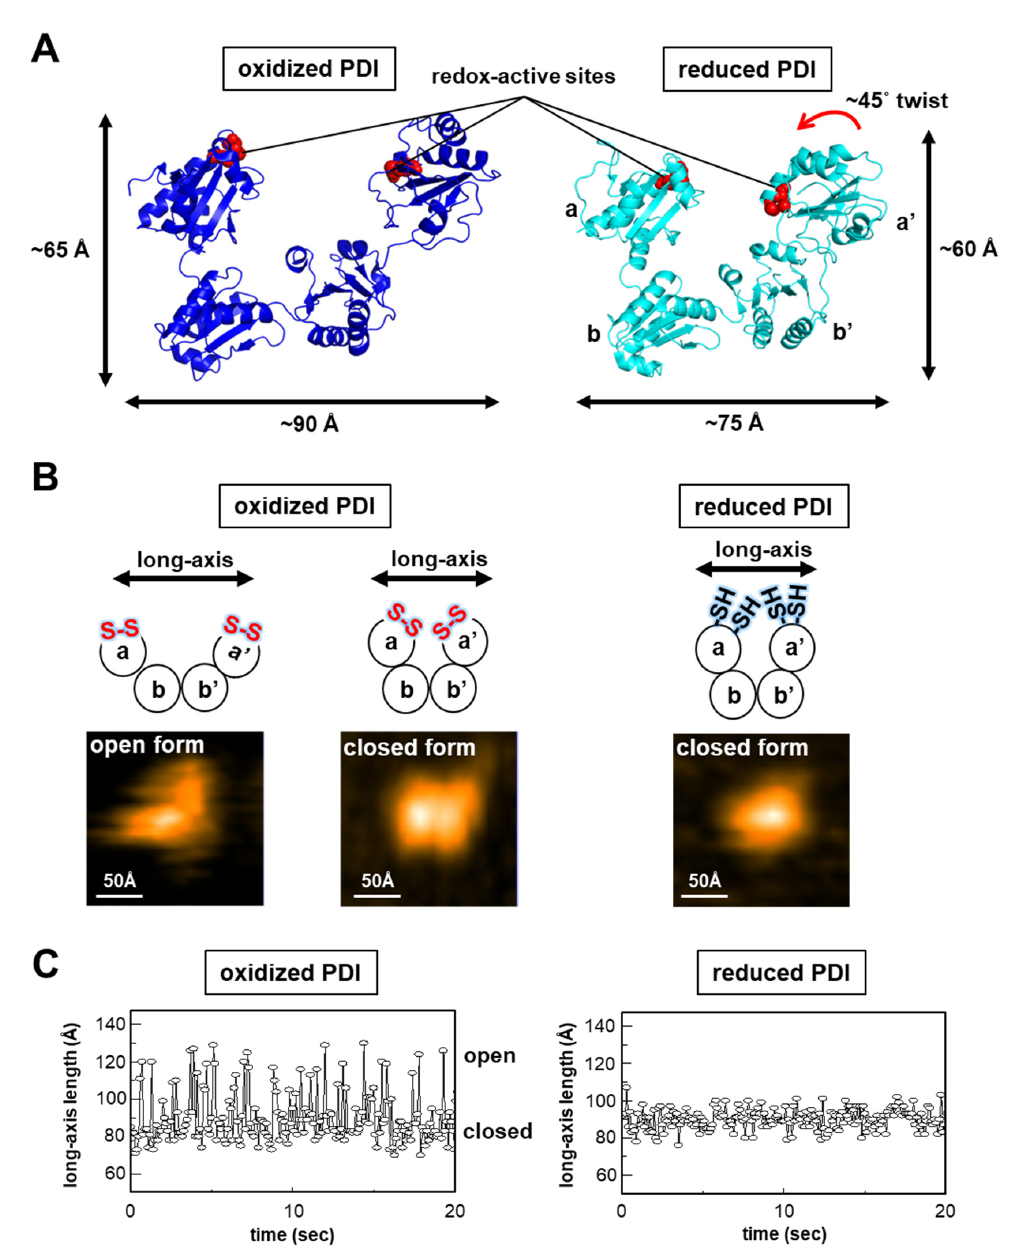
Figure 1. Redox-regulated dynamic nature of the human protein disulfide isomerase (PDI) molecule. ( A ) Left and right panels show crystal structures of oxidized PDI (Protein Data Bank (PDB) code: 4EL1) and reduced PDI (PDB code: 4EKZ) from human , respectively. Redox-active sites of oxidized and reduced PDI are indicated by red sphere. ( B ) High-speed atomic force microscopy (HS-AFM) images (lower; scan area 200 × 200 Å 2 ; scale bar 50 Å) of oxidized (left) and reduced (right) forms of human PDI. ( C ) Time trace of the long-axis length for oxidized (left) and reduced (right) forms of human PDI.